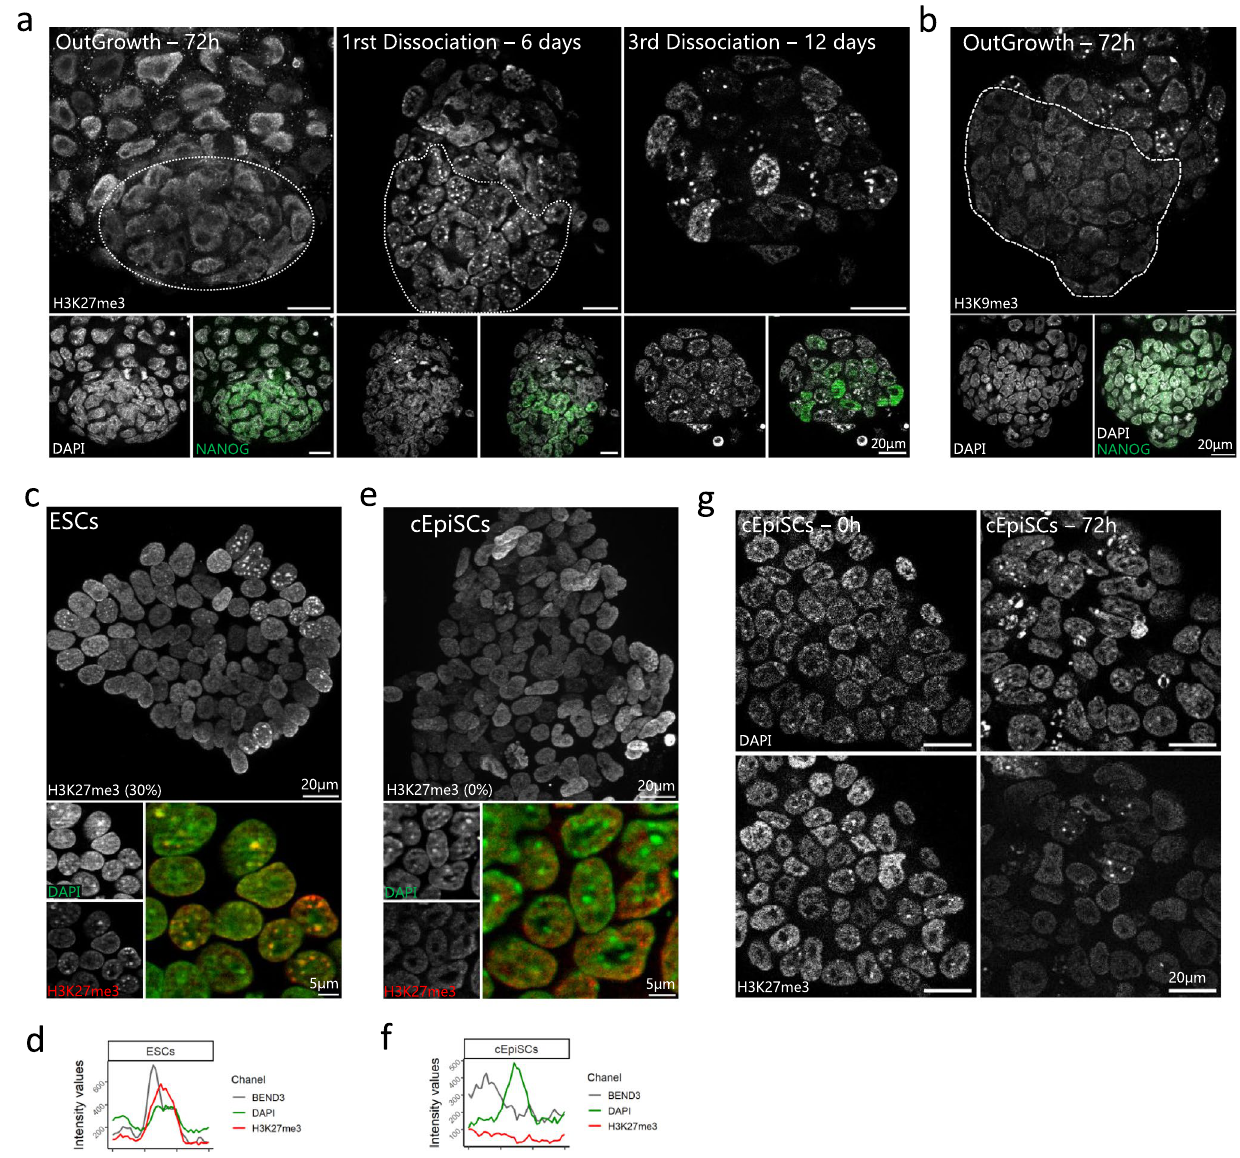
Figure 7. Comparative H3K27me3 enrichment at chromocenters during ESCs derivation and cEpiSCs conversion. ( a ) From left to right: H3K27me3 staining profile at different time points of ESC derivation from blastocysts cultured in 2i/LIF medium. ( b ) H3K9me3 staining in 72 h outgrowth. For ( a ) and ( b ), DAPI and NANOG staining are presented in the lower panels. The pluripotent cell population is delineated by a white dashed line. ( c , e ) ESCs and 10 days converted EpiSCs ( e ) colony stained for H3K27me3 (red), DAPI (green) and merge signals. ( d , f ) The graphs show the intensity profiles of DAPI, H3K27me3 and BEND3 signals across a single chromocenter for ESCs ( d ) and cEpiSCs ( f ). ( g ) Dynamics of H3K27me3 disappearance at 0 and 3 days post-medium switching from 2i/LIF to FGF2/Activin. Graphs were generated using ggplot2 56 (v3.3.5) in R and figures were arranged with FigureJ 55 in Fiji 54